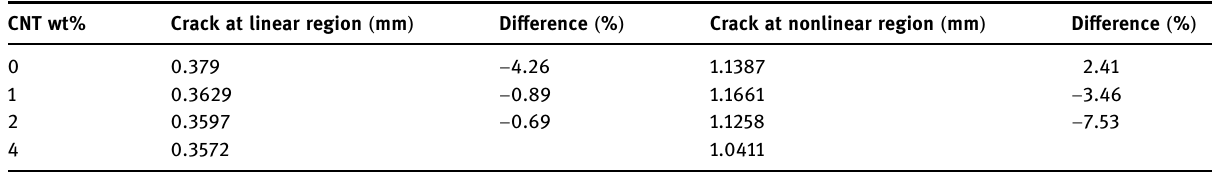
Table 15: Crack width at the bottom center of the beam ( load = 1,150 kN